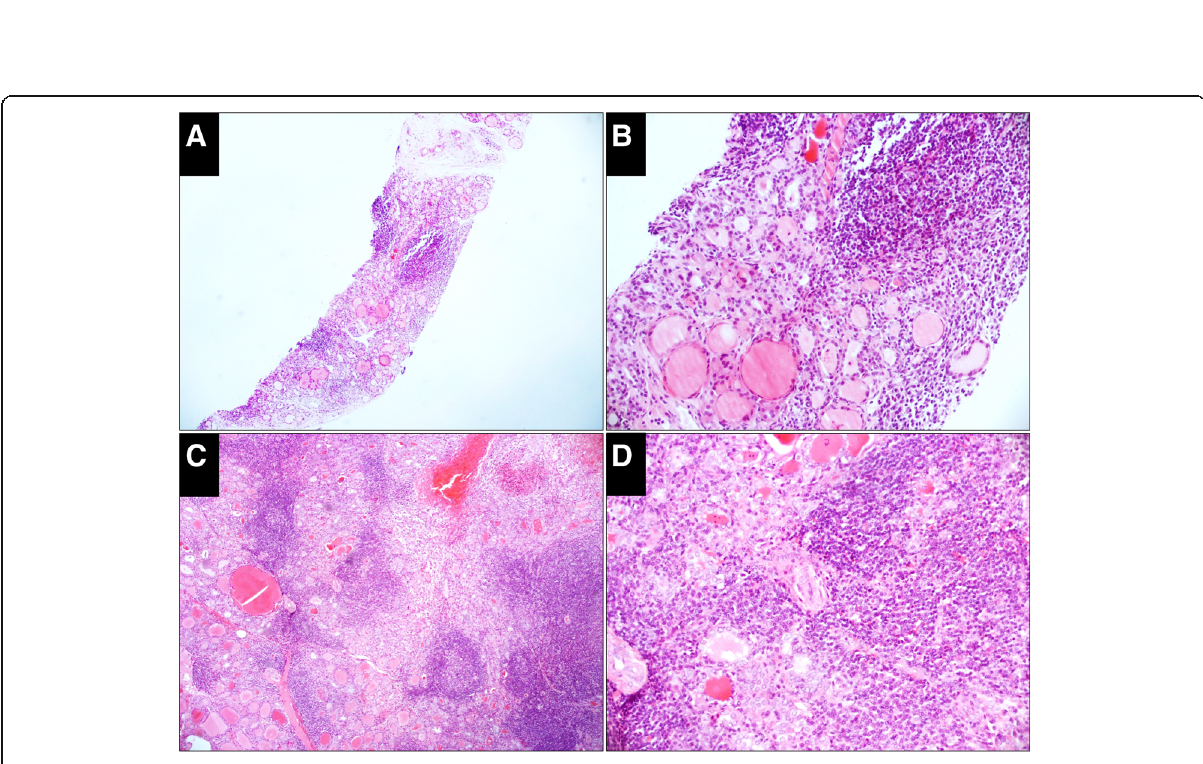
Fig. 2 Case classified as benign both in the CNB and resected specimens (H&E). a, The CNB specimen consists of thyroid follicles and many lymphoid tissues with lymphatic follicles (× 50). b , Thyroid follicles are atrophic with oncocytic metaplasia (× 200). c (× 50), d (× 200), The change in the thyroid follicles and the proliferation of lymphoid tissues in the resected specimen is the same as that in the CNB